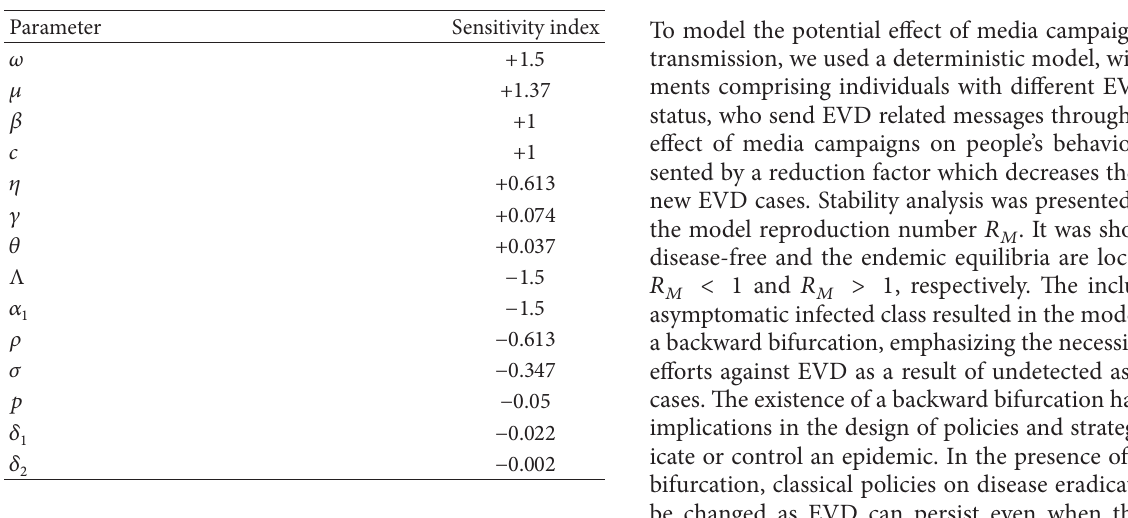
Table 3: Sensitivity indices for EVD reproduction